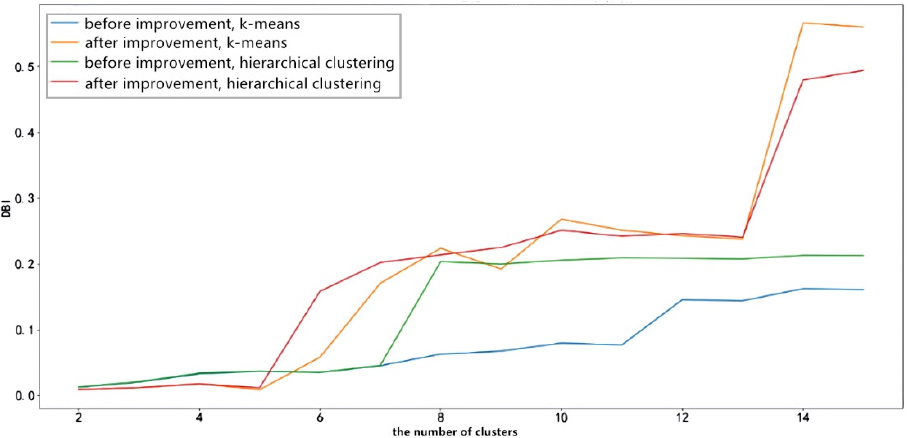
Figure 8. Comparison diagram of clustering DBI index before and after improvement.